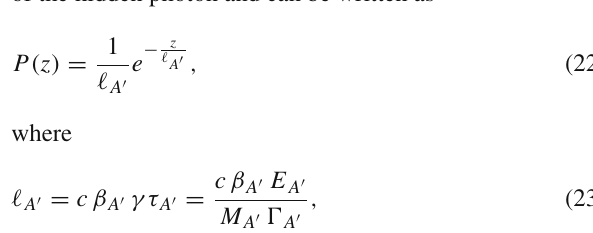
G 2 ( t ) of the nucleus as